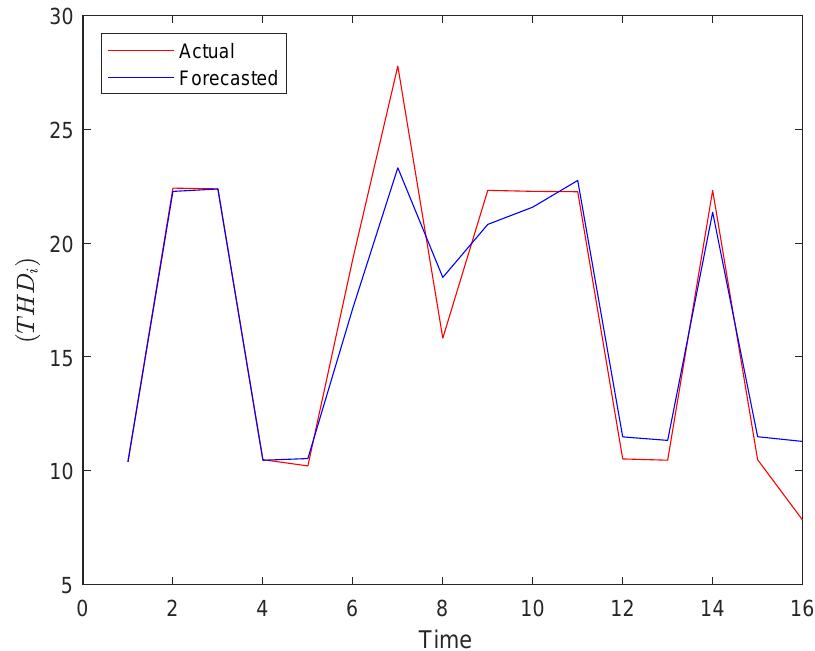
Figure 11. Comparison of actual and forecasted THD i when using